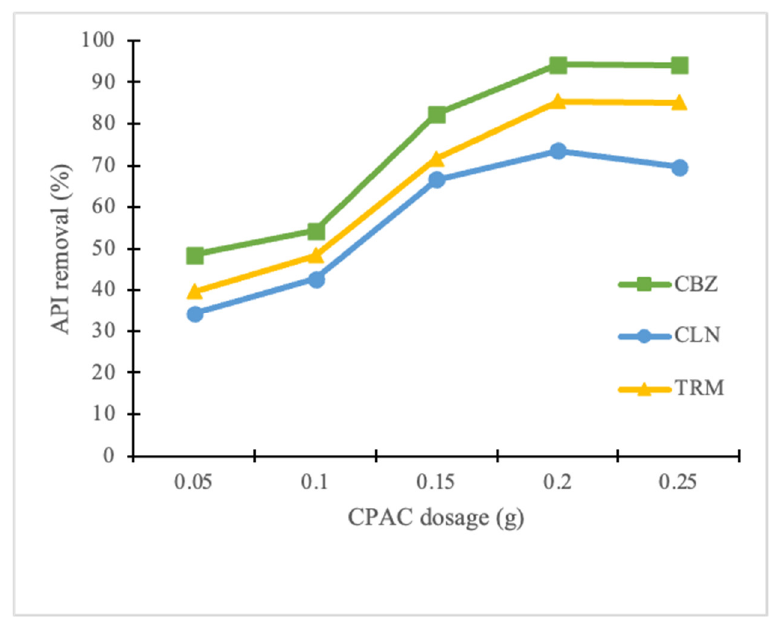
Figure 3. Effect of the CPAC dosage on the API removal.